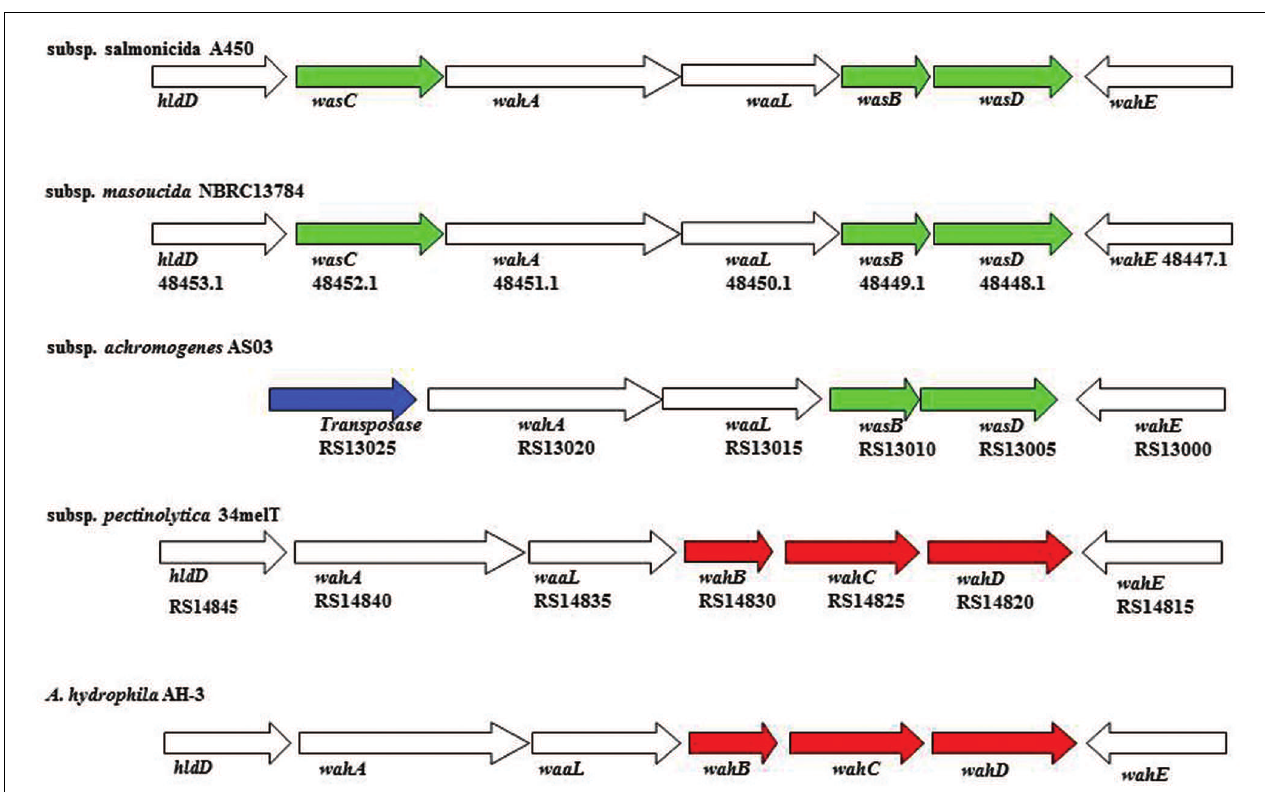
FIGURE 3 | The genes in region 1 of A. salmonicida waa from subspecies salmonicida A450; subspecies masoucida strain NBRC13784; subspecies achromogenes strain AS03; subspecies pectinolytica strain 34melT; and A. hydrophila strain AH-3. The genes in green are unique for A. salmonicida strains, in red are initially unique for A. hydrophila strains, no color are shared by both species. The transposase is labeled in blue. The identity percentage of all the genes analyzed is over 97%.